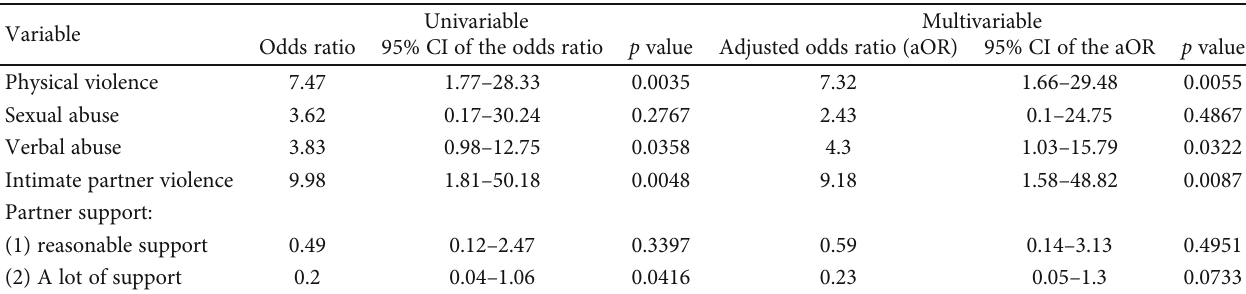
Table 8: Univariable and multivariable logistic regression analysis investigating the in fl uence of selected variables on depression during the postpartum